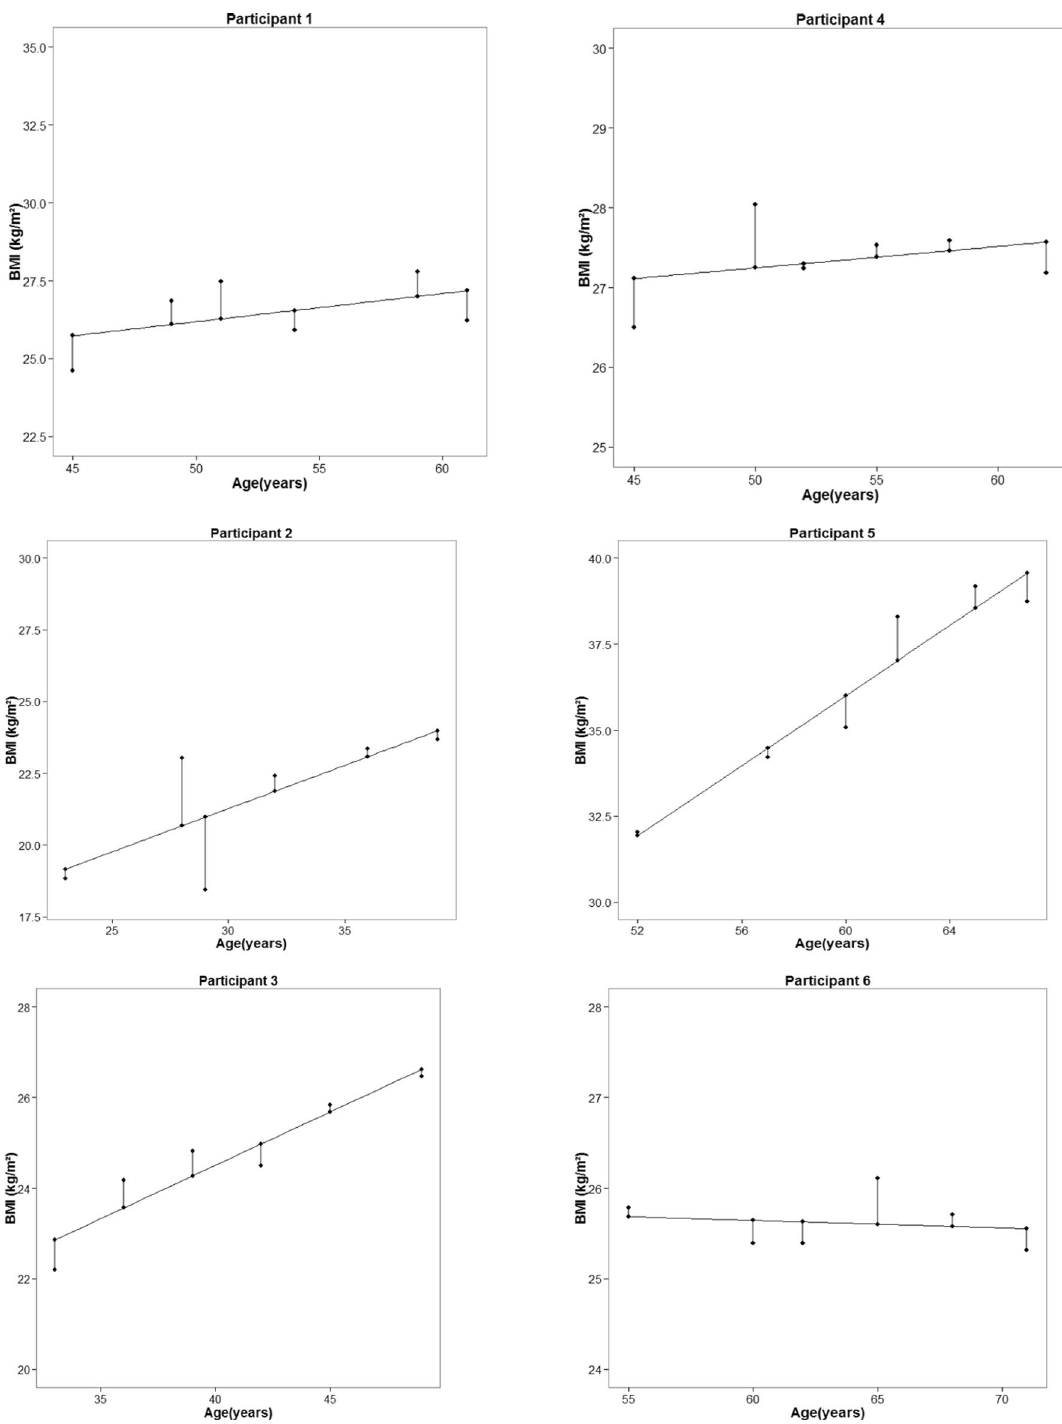
Figure 1. Observed and fitted values of BMI change and residuals from 6 randomly selected male and female participants (Left: Males, Right: